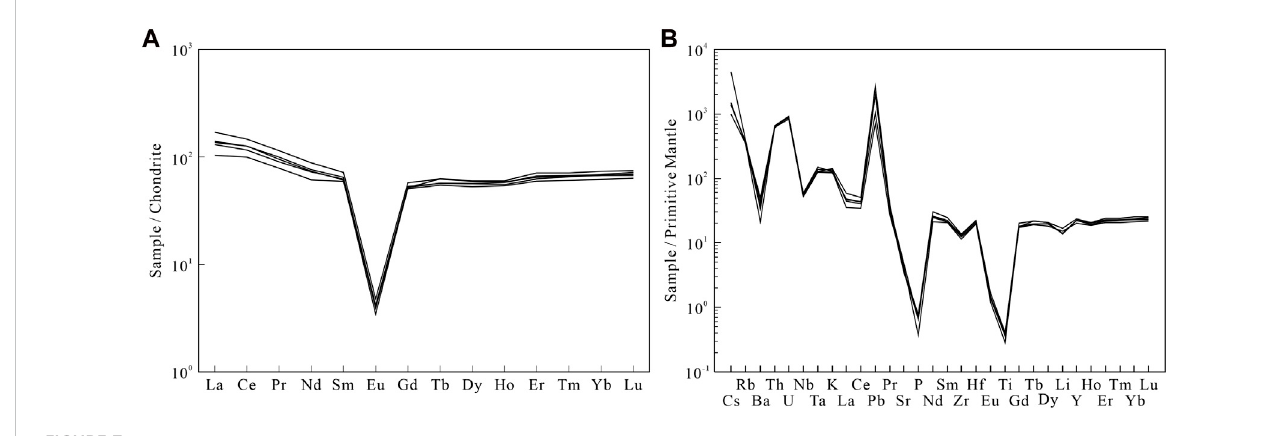
FIGURE 7 Chondrite-normalizedREEpatterns (A) andprimitivemantle-normalizedmulti-elementdiagrams (B) forBHSGandFQSG(thenormalizationvaluesafter Sun and McDonough,